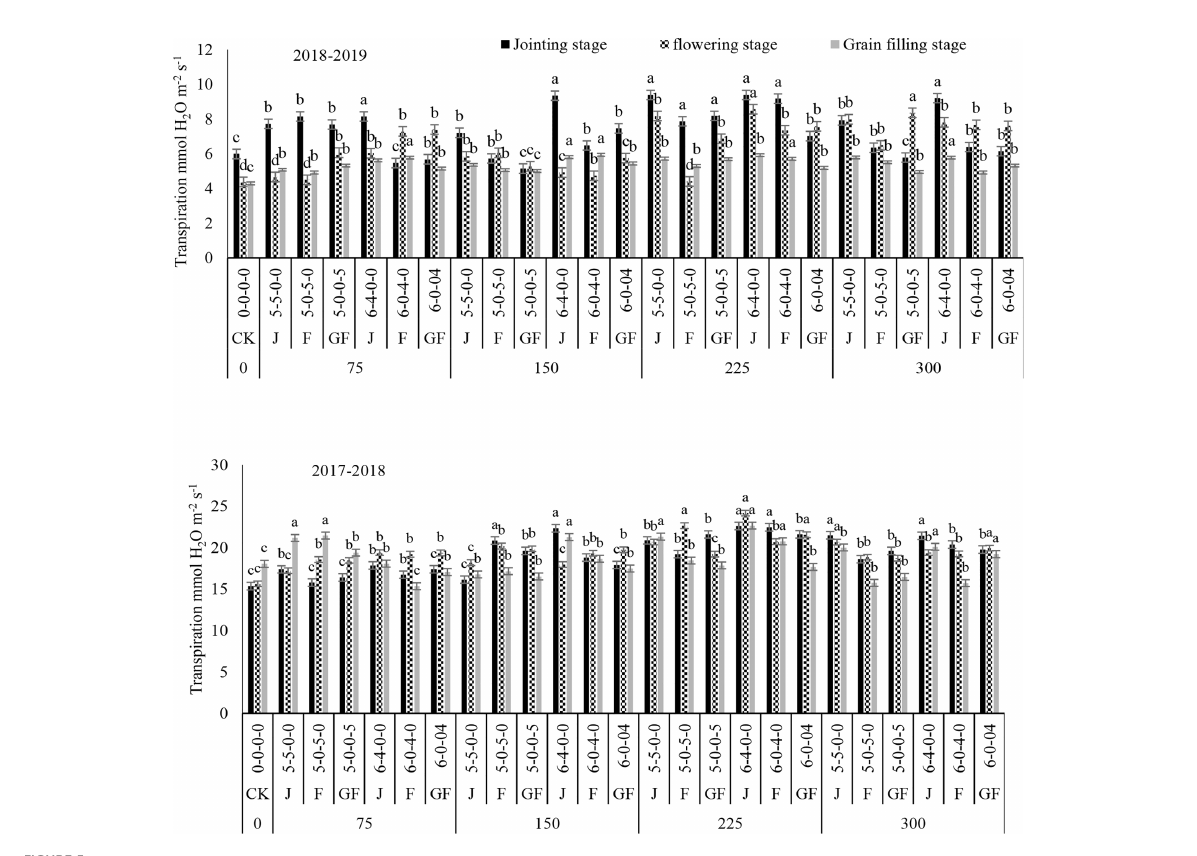
FIGURE 5 Effect of nitrogen fertilizer management on the transpiration rate of winter wheat. JS , jointing stage; FS , fl owering stage; GF , grain fi lling stage. Different letters in above bars indicate a signi fi cant difference (p>0.05).